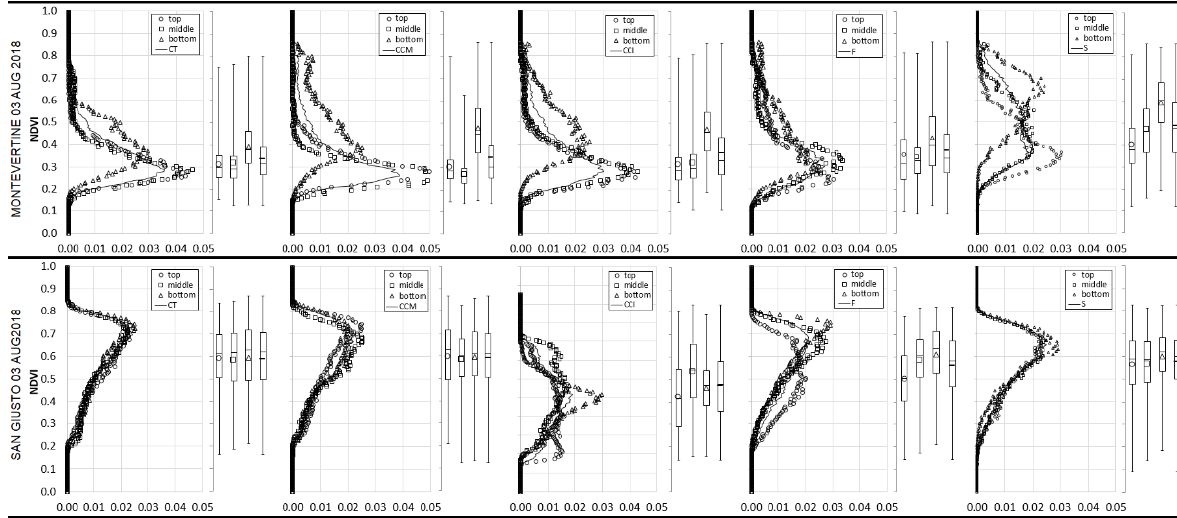
Figure 6. Distribution frequency of the NDVI pixels and boxplots obtained for the entire vine row treatment and for the three subplots (top; middle; bottom) localized along the slope gradient.